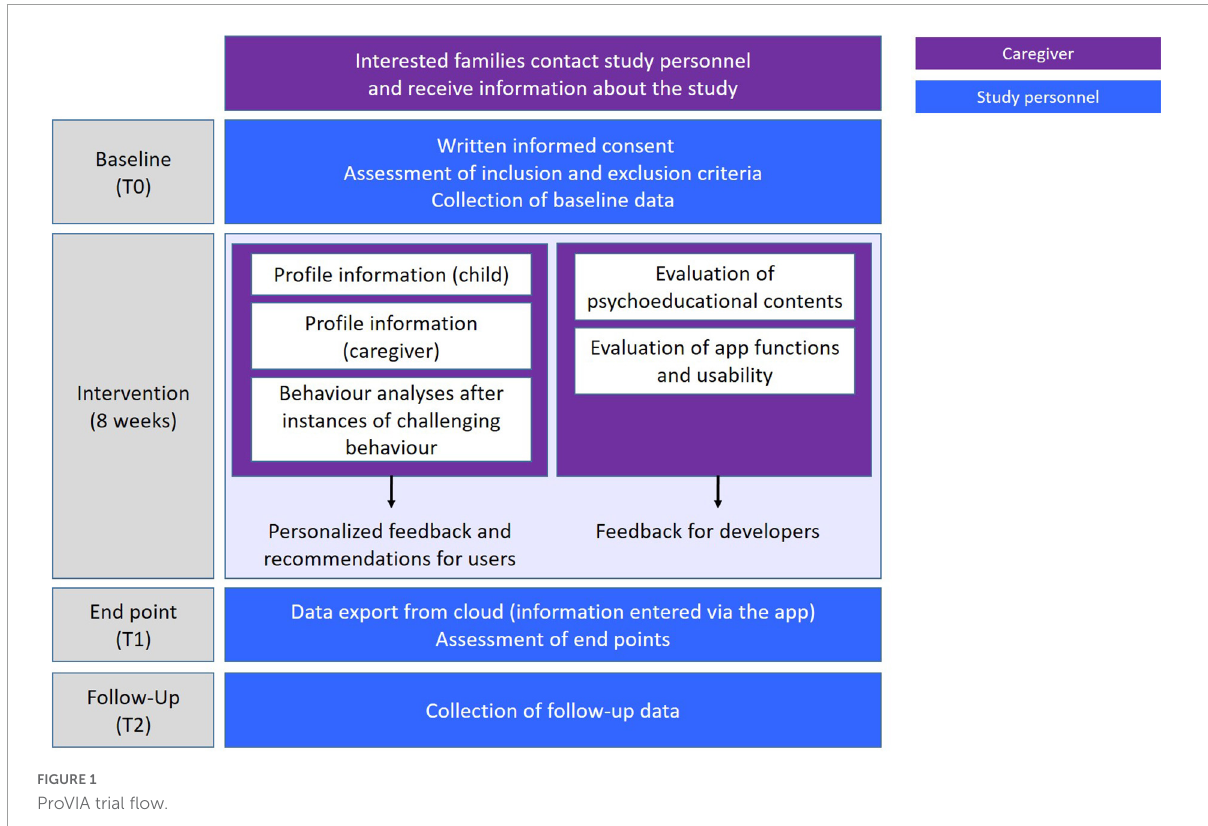
FIGURE1 ProVIA trial